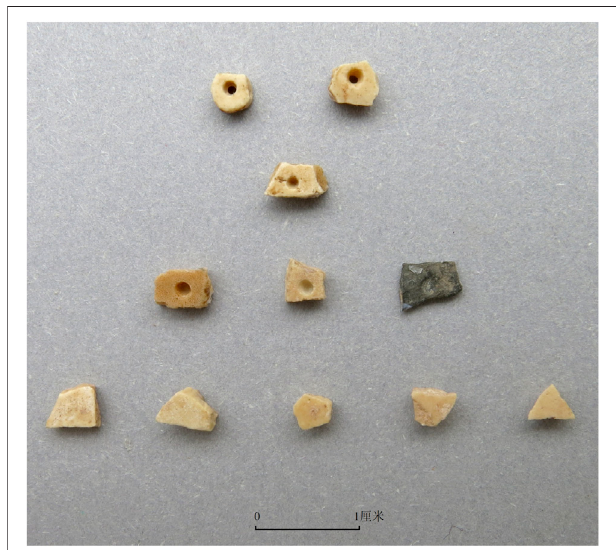
FIGURE 5 | Perforated OES beads (top), preforms (rows 2, 3), and blanks(bottomrow)fromShizitanSZT9.Row1.Perforatedpieces;Row2.Bi- directionally drilled piece; Row 3. Uni-directionally drilled pieces; Row 4. Blanks or remnant pieces. Scale is 1